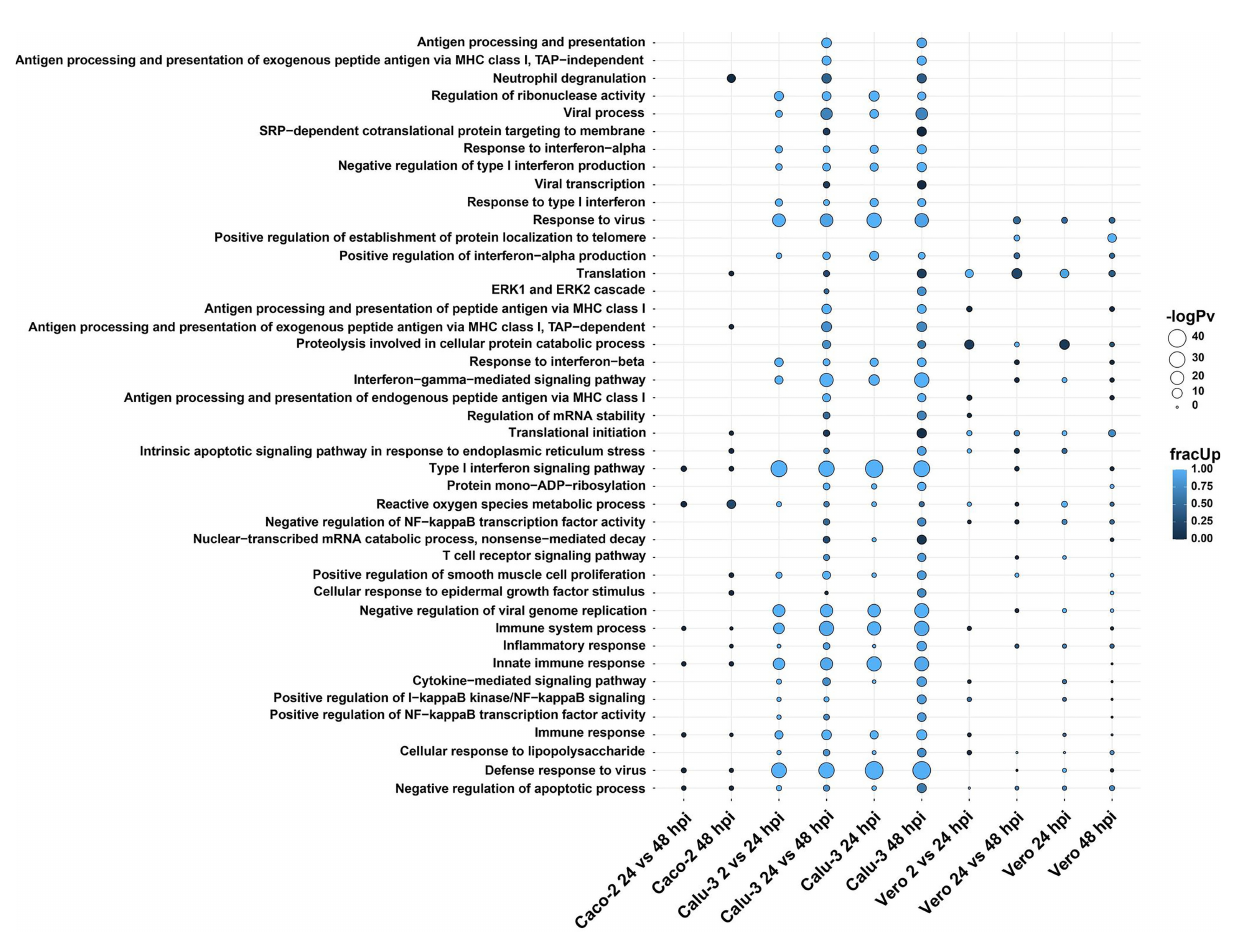
FIGURE 3 | GO biological terms of differentially expressed genes in Calu-3, Caco-2 and Vero direct cDNA datasets analyzed by DESeq2 and visualized with multiGO . Results include datasets (in order); Caco-2 24 vs 48, Caco-2 48, Calu-3 2 vs 24, Calu-3 24 vs 48, Calu-3 24, Calu-3 48, Vero 2 vs 24, Vero 24 vs 48, Vero 24 and Vero 48 hpi. Commonly enriched GO terms across the three cell lines involved the ROS metabolic process , indicating the importance of mitochondrial processes during SARS-CoV-2 infections. The bubble size and color indicate the -log10 enrichment p-value and fraction of upregulated genes, respectively. Thresholds of padj < 0.05 and enrichment p-value < 1E-6 in at least one dataset were used for generating the plot, where insigni fi cant bubbles are also shown on the plot. All terms with padj < 0.05, enrichment p-value < 0.05 involving at least two genes were deemed as signi fi cant for the analysis. Related to Figure S2 and Data S2 .